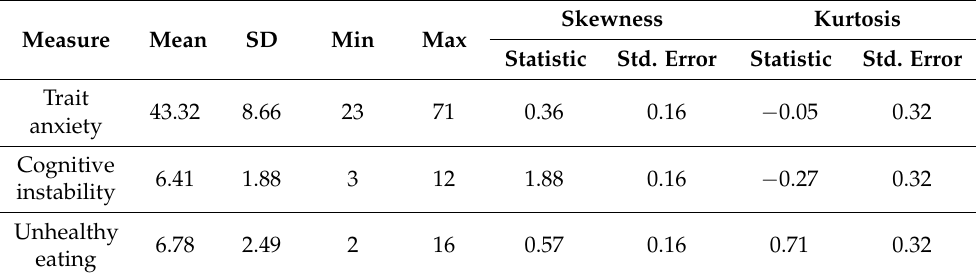
Table 4. Mean, standard deviation, minimum, maximum, skewness, and kurtosis values of anxiety, cognitive instability, and unhealthy eating for adult women (N = 225).